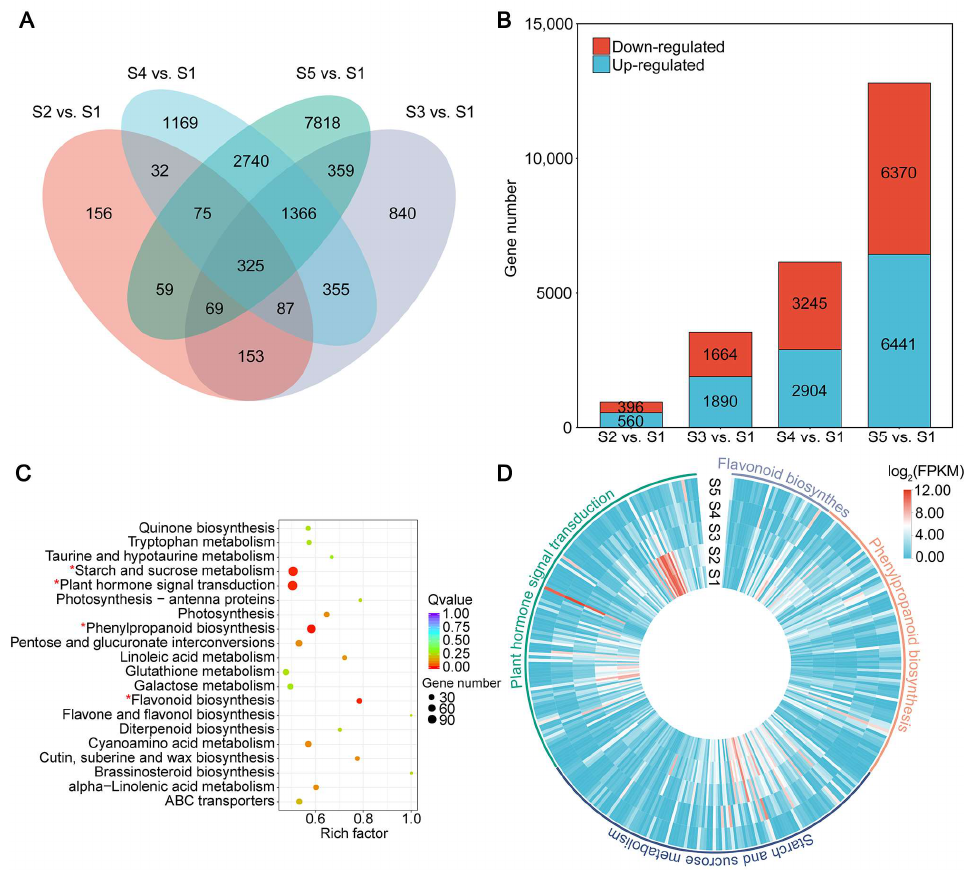
Figure 3. Summary of differentially expressed genes (DEGs) identified in the common vetch seed transcriptomes. ( A ) Venn diagrams of DEGs detected in S2 vs. S1, S3 vs. S1, S4 vs. S1, and S5 vs. S1.